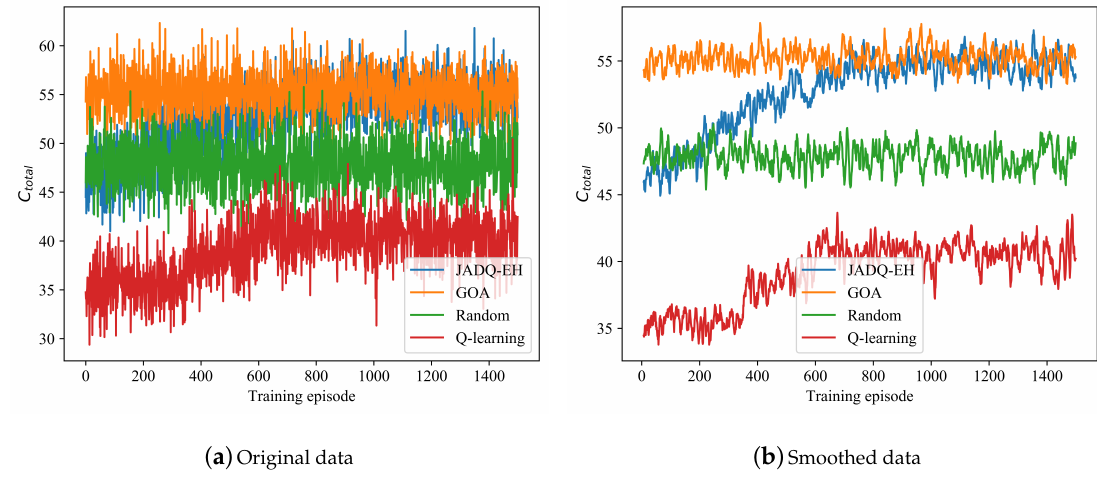
Figure 5. C total comparison of different algorithms under scenario 1.